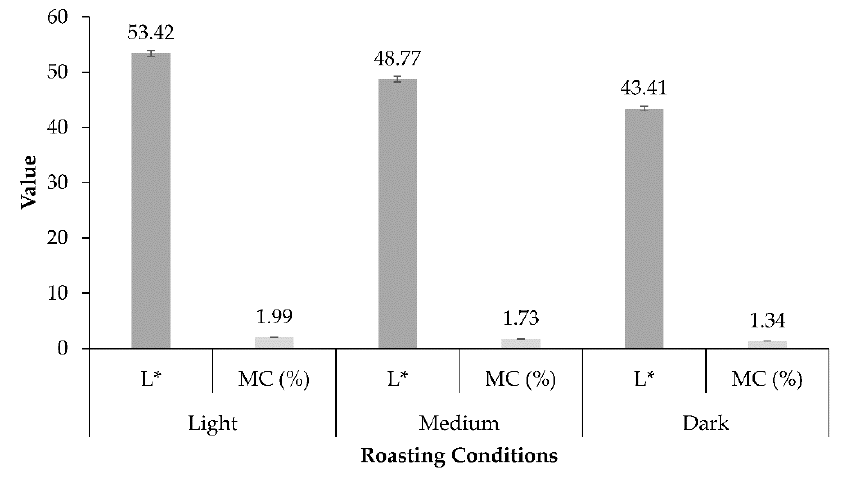
Figure 5. Average experimental values of MC and L*.